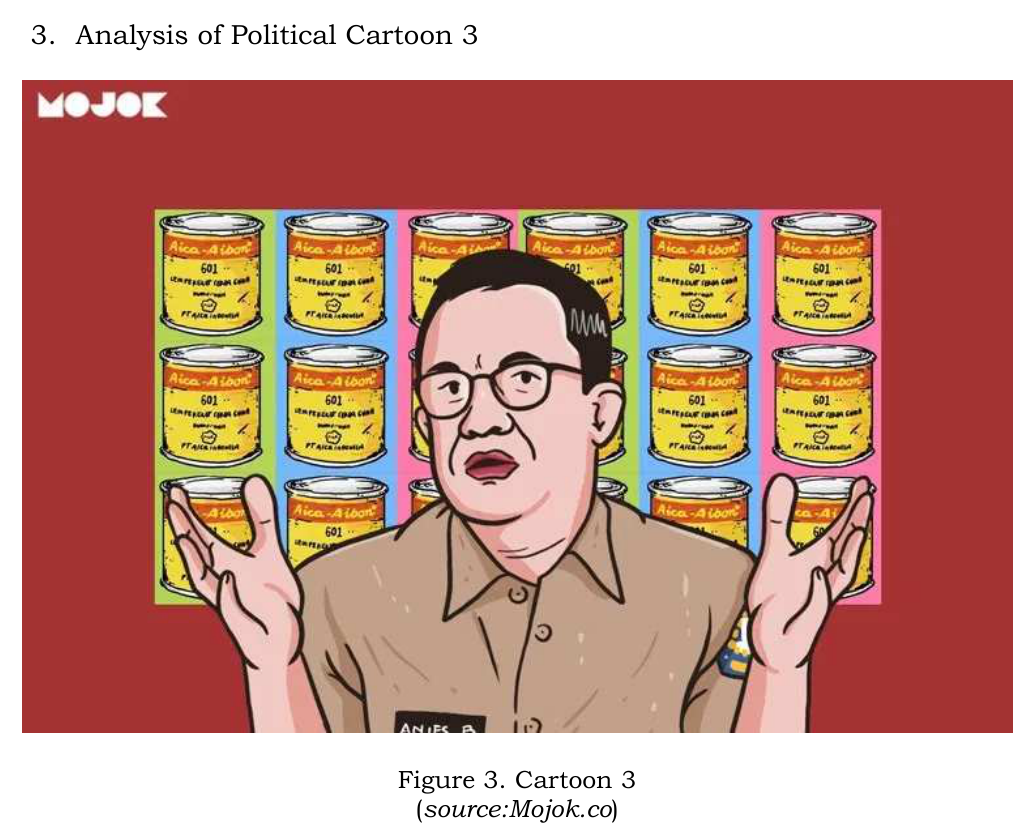
Figure 3. Cartoon 3 ( source:Mojok.co )